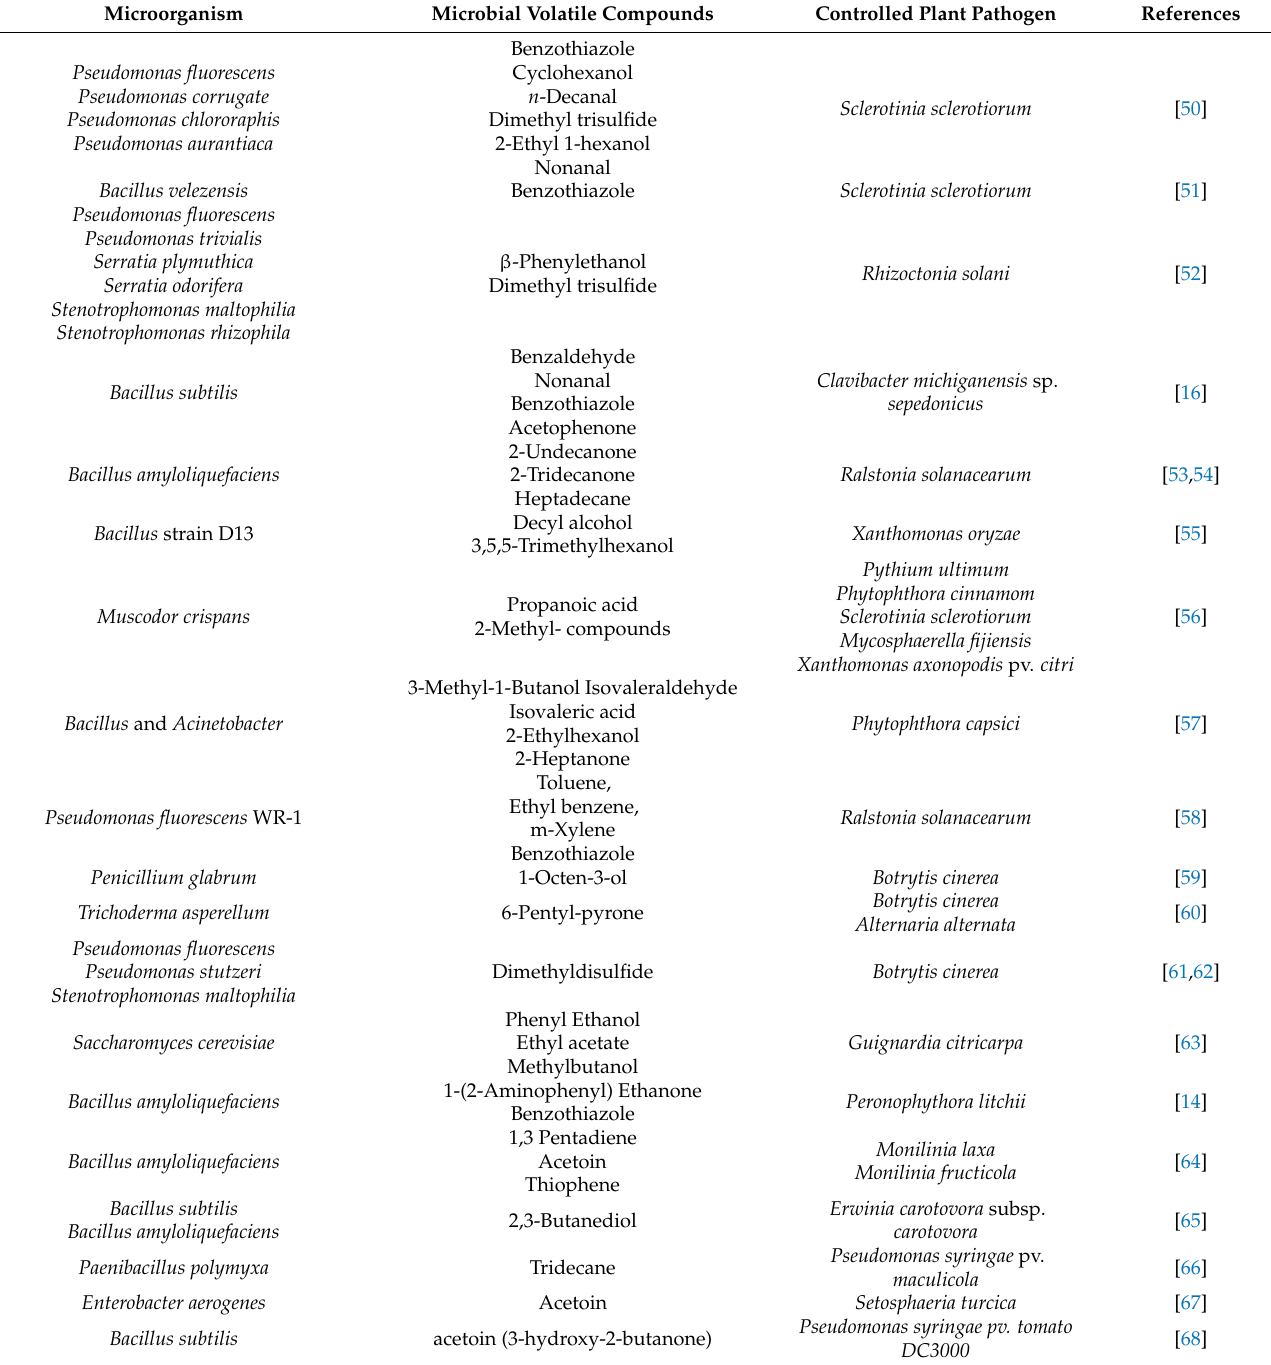
Table 1. Summary of microbial volatile compounds and their plant disease